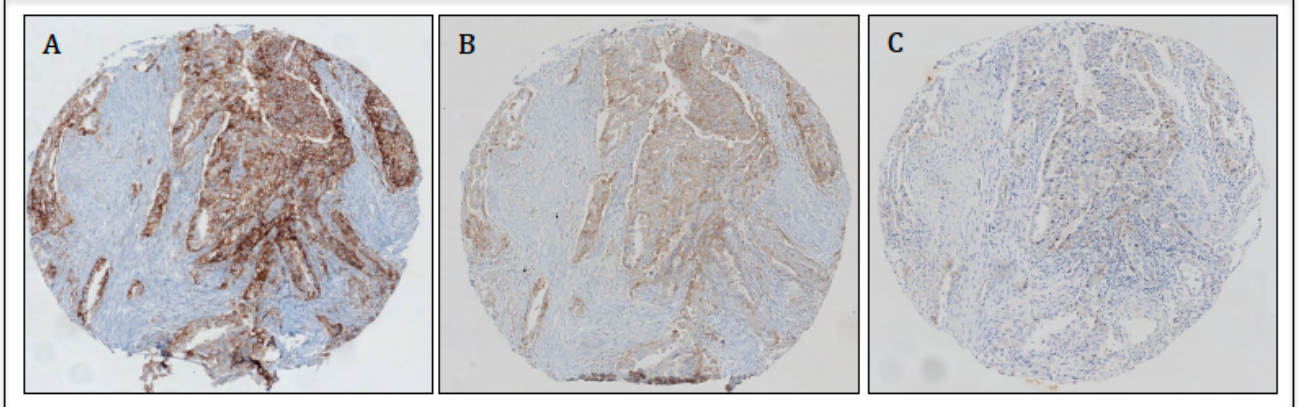
Figure 1. Representative image of PD-L1 expression on the same core with different assays (10× magnification): ( A ) SP263 on Ventana platform; ( B ) 22C3 on Ventana platform; ( C ) 22C3 on Dako platform.